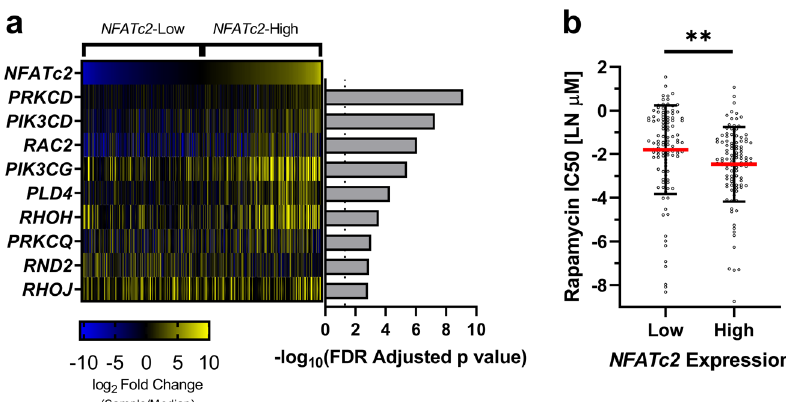
Fig. 3 In vitro data identi fi es relationship between NFATc2 expression and the mTOR pathway. Data from the Genomics of Drug Sensitivity in Cancer database, including DNA variants, mRNA expression, and drug sensitivity, were collected for 1002 cell lines. To reduce the effect of DNA level variants on the mTOR pathway, cell lines identi fi ed to have known cancer driver genomic variants in PTEN , mTOR , TSC1 , or TSC2 were excluded from our analysis. Cell lines were divided into NFATc2 -Low and NFATc2 -High categories by median NFATc2 expression. Differential expression was followed by pathway analysis. NFATc2 -High lines exhibited activation of the mTOR pathway ( z -score = 5.0, p < 0.0001). a Heatmap of mTOR pathway genes from pathway analysis identi fi ed to be differentially expressed between NFATc2 -Low and NFATc2 -High cell lines. b NFATc2 -High lines were more sensitive to the mTOR inhibitor rapamycin (mean ± SD: NFATc2 -Low − 1.8 ± 2.0, NFATc2 -High − 2.5 ± 1.7, p = 0.009). Plot represent the center line as the mean, error bars as ±SD. ns not signi fi cant; * p ≤ 0.05; ** p < 0.01; *** p <